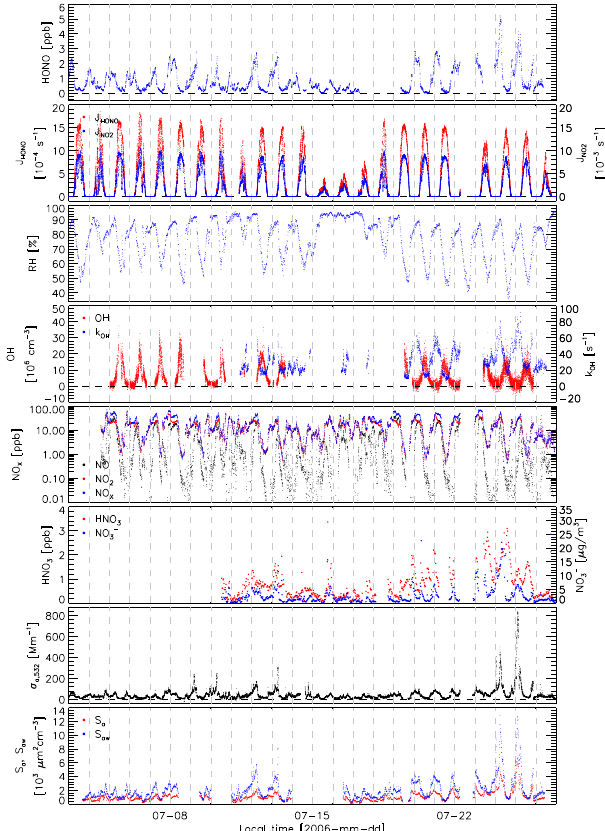
Fig. 2. Time series of HONO, J HONO , J NO NO 2 , NO x , gas phase HNO 3 , aerosol light absorption ( σ a , 532 ), aerosol surface density ( S a ) and RH corrected aerosol surface den- sity ( S aw ) at the Back Garden supersite in July